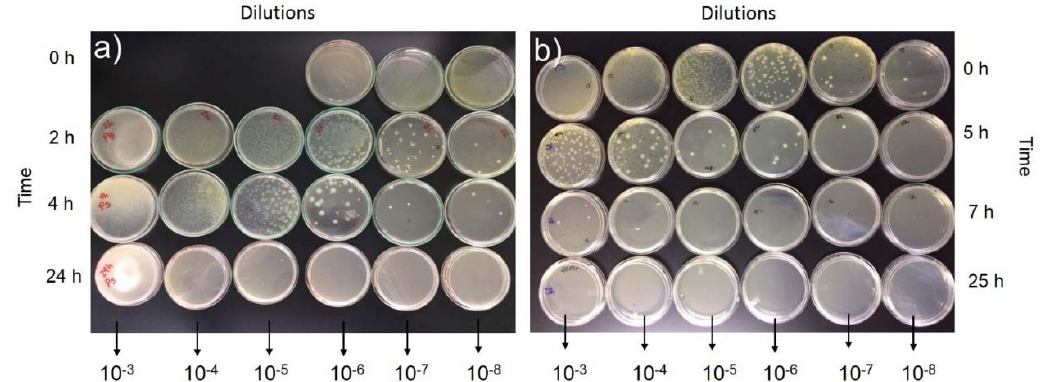
Figure 10. Reduction in the number of viable bacteria over time in the P. aeruginosa agar for ( a ) GP and ( b ) GP-G.